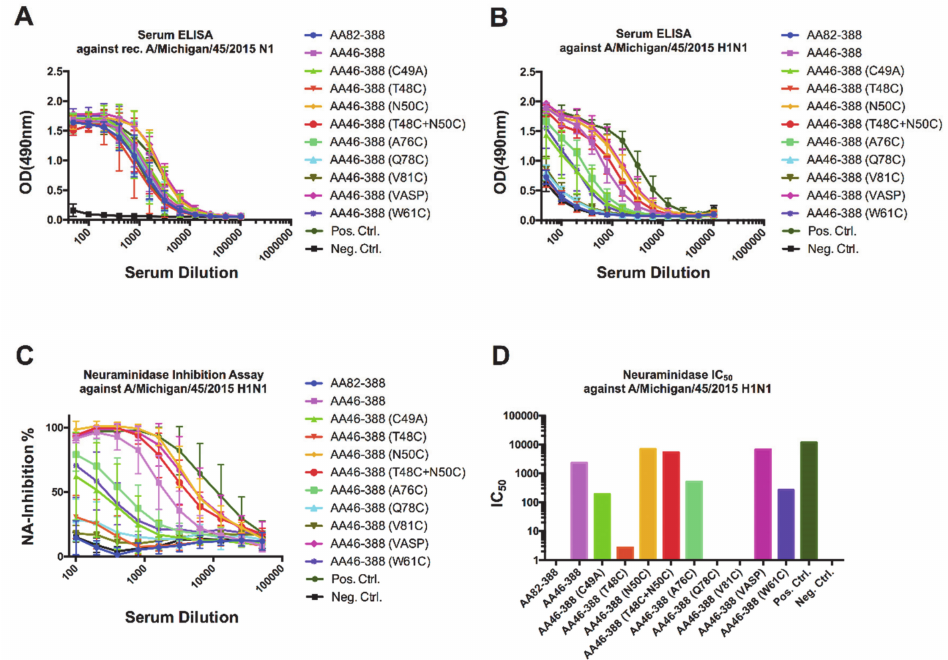
Figure 4. Characterization of anti-NA antibody responses in sera from vaccinated samples. Pre-challenge samples (after the 2nd vaccination) were obtained from the different groups of mice. Antibodies in serum able to bind to a recombinant tetrameric Mich15-VASP protein ( A ) or to the A/Michigan/45/2015 H1N1 virus ( B ) were measured by ELISA. The ability of serum antibodies to inhibit the neuraminidase enzymatic activity was assessed using the A/Michigan/45/2015 virus ( C ). The 50% inhibitory concentration (IC 50 ) for each pool of serum samples is shown ( D ).